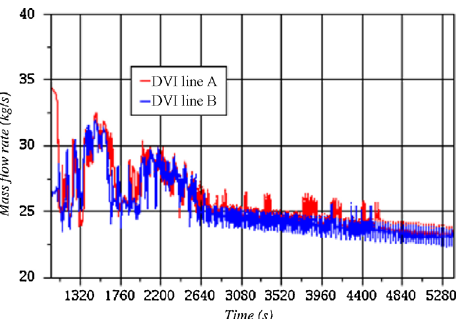
Fig. 19. Total injection mass fl ow from 1000 s to 5400 s (kg/s).